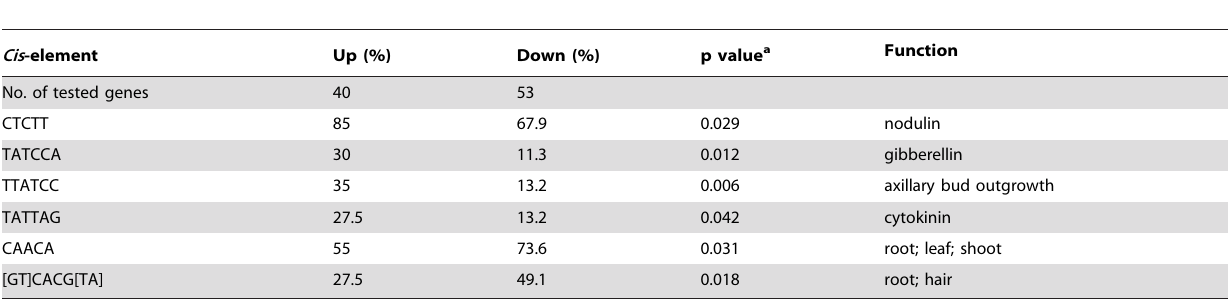
Table 4. Identification of distinct cis -regulatory elements in the DEGs shown the same expression pattern in at least two different